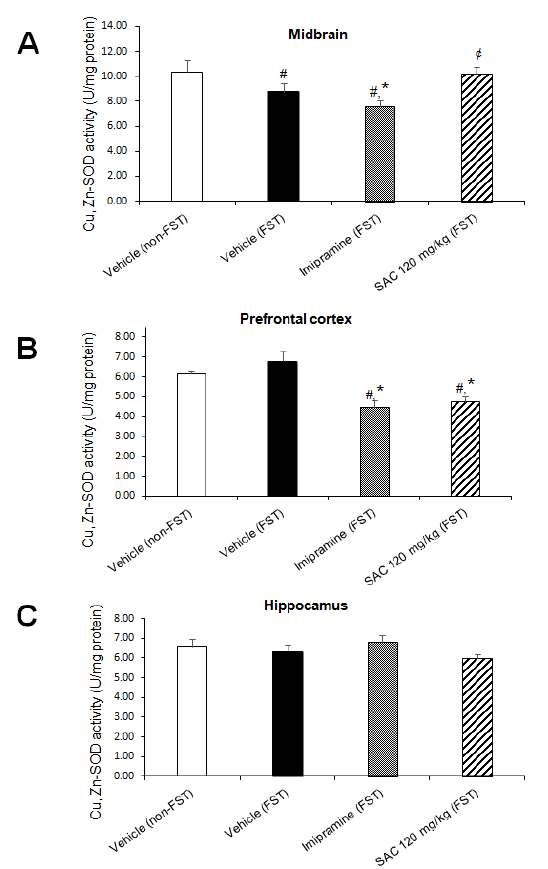
Figure 7. The antidepressant-like response of SAC (120 mg / kg) in the FST is related with downregulation of Cu,Zn-SOD activity in prefrontal cortex. The vehicle (non-FST or FST), imipramine (FST) or SAC (FST) were the treatment groups. Cu,Zn-SOD was analyzed in the midbrain ( A ), prefrontal cortex ( B ), and hippocampus ( C ). Results are expressed as mean ± SEM of 6 – 8 animals per group. The one-way ANOVA followed by post hoc Duncan’s tests was used to analyze the differences among groups. (#) Statistically different from the non-FST group, p < 0.05, Duncan’s test; (*) statistically different from the vehicle-FST group, p < 0.05, Duncan’s test; (¢) statistically different from the imipramine-FST group, p < 0.05, Duncan’s test. Cu,Zn -SOD = copper, zinc-superoxide dismutase; FST = forced swimming test; SAC = S-allyl cysteine.